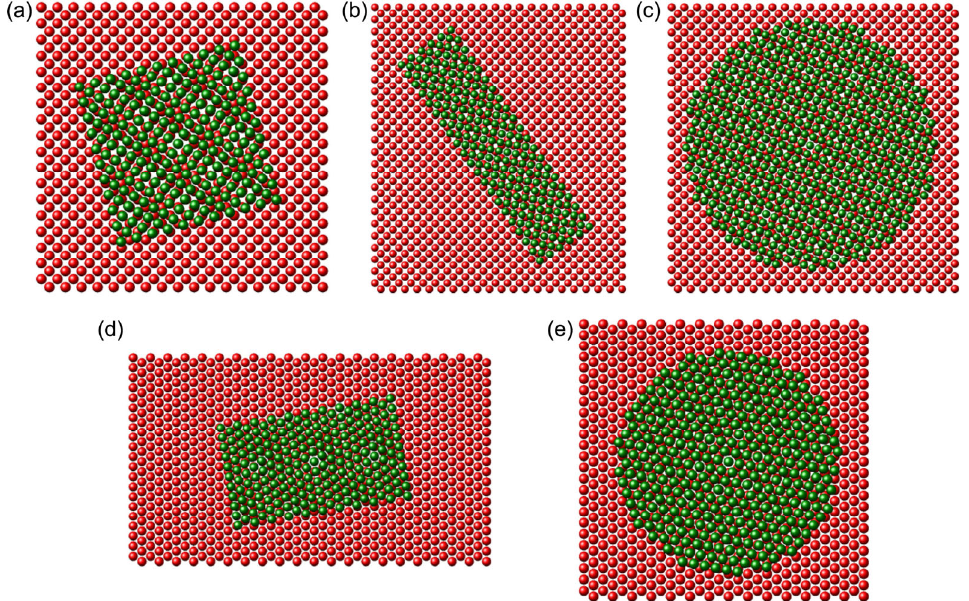
Fig. 2 Simulated systems. The top view of two contact surfaces is shown here. The lower surface is colored in red and the upper surface is colored in green. (a − c) Cases in square lattice (both surfaces are <100> planes of the FCC lattice), (d, e) cases in hexagonal lattice (both surfaces are <0001> planes of the HCP lattice). For each system, both surfaces contain three layers of atoms. The detailed size of the upper surface is listed in Table S2 (in the Electronic Supplementary Material (ESM)). The size of the lower surface is slighted larger to ensure that the minimum distance between two adjacent upper surfaces under periodic boundary conditions is greater than the cutoff distance 2.5 σ